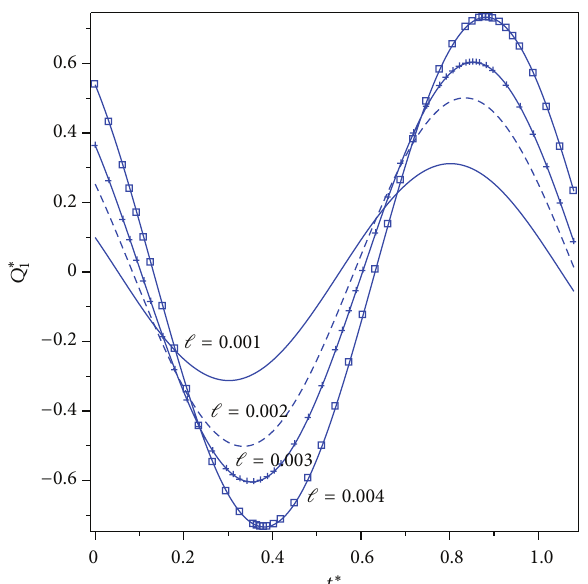
Figure 10: Influence of ratio 𝜀 of 𝑏/𝑎 and slip length ℓ on the amplitude of the flow rate on the cross-section of the channel with constant area of 1.0 × 10 −6 m 2 under the frequency 𝜔 = 𝛼/𝜌𝑎 2 with 𝛼 = 0.005